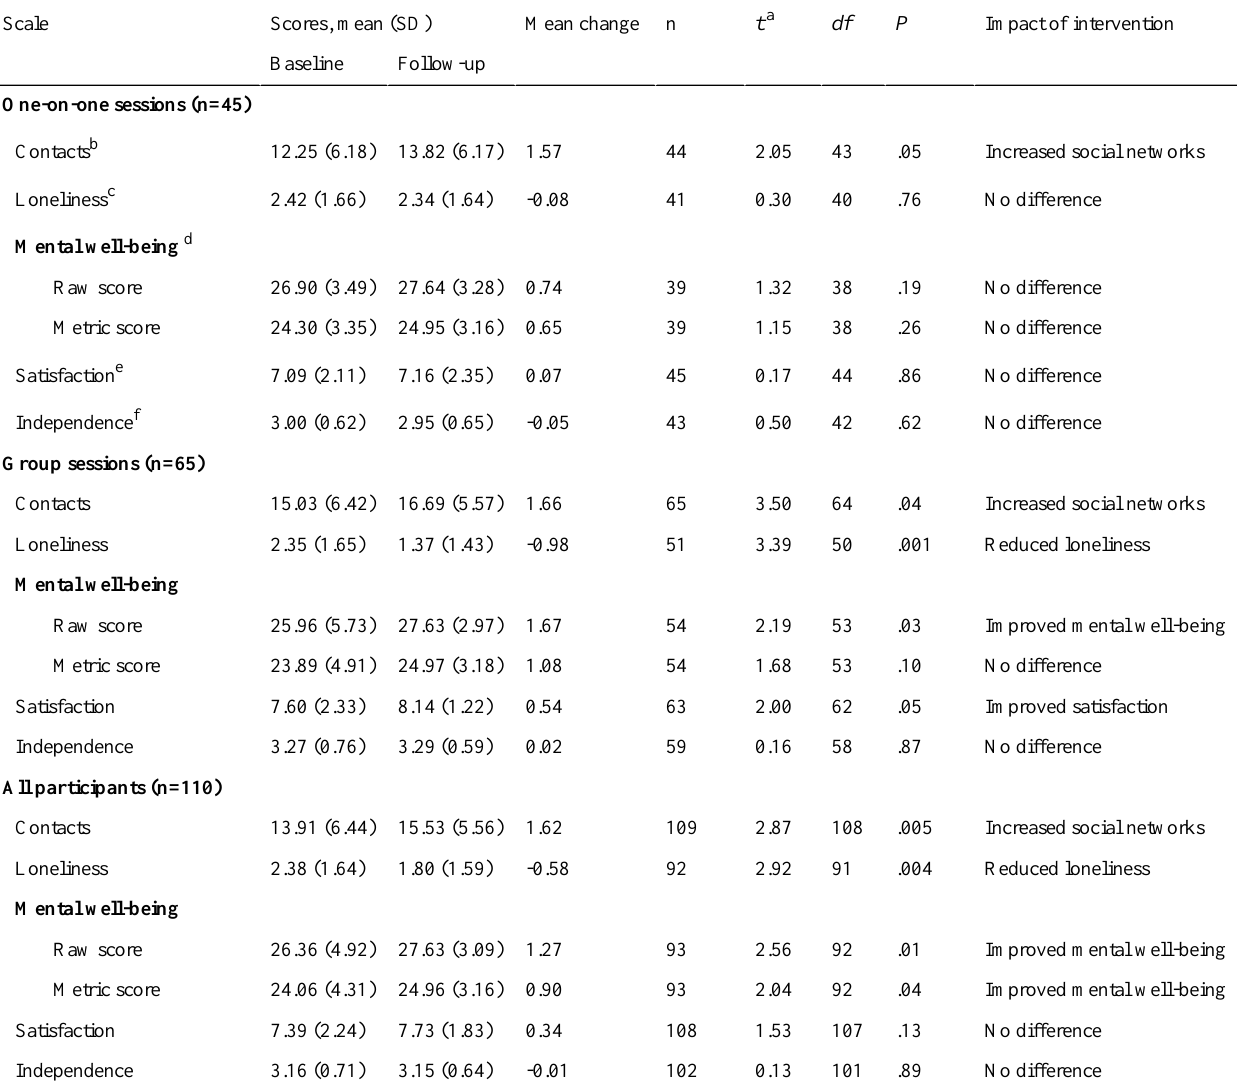
Table 2. Mean scores and significance of score changes from baseline to follow-up for up to 110 participants for various measurements by intervention and for all